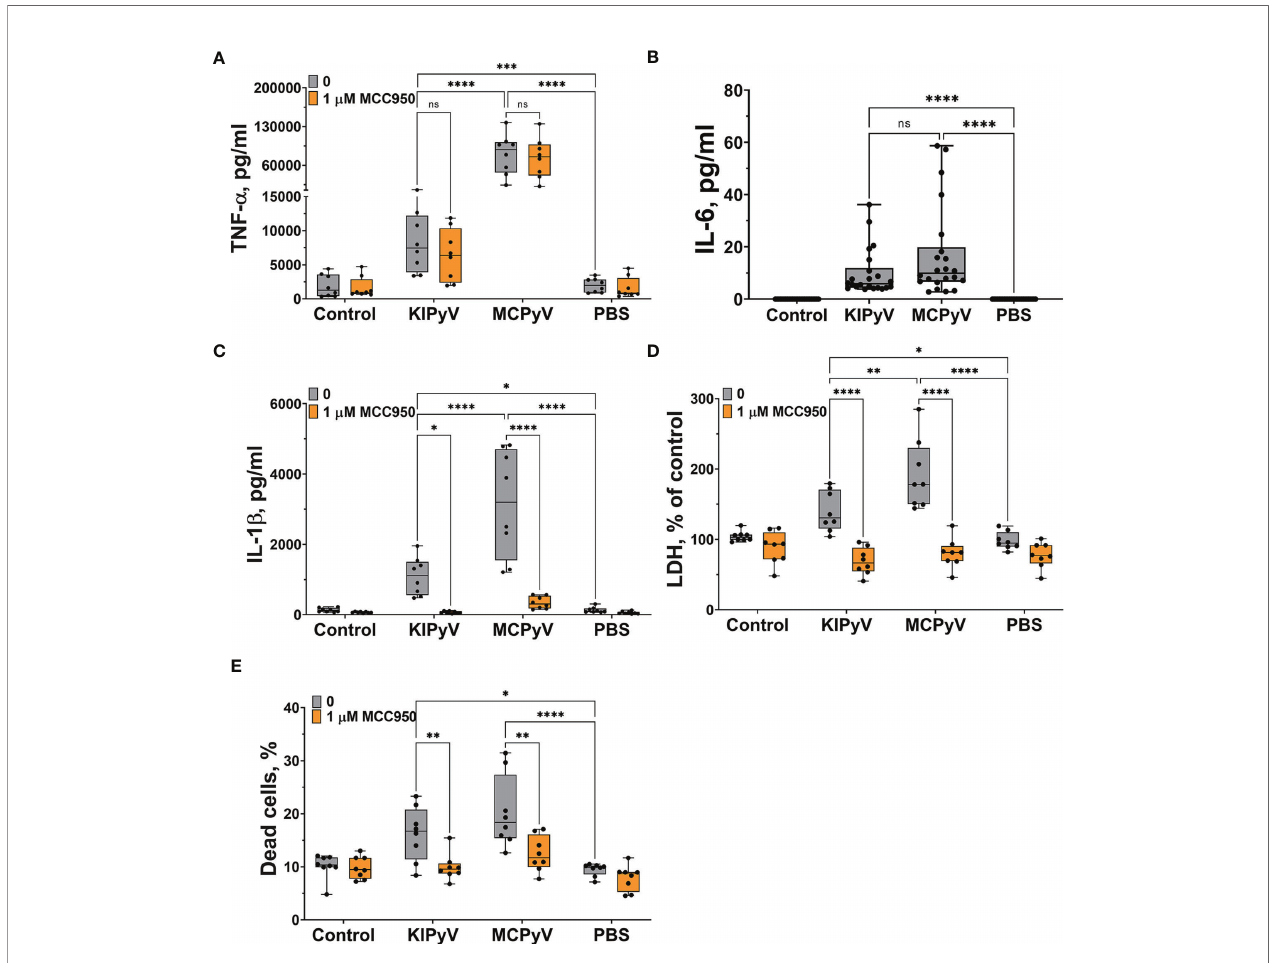
FIGURE 2 | PyV-derived VLPs induced release of in fl ammatory cytokines TNF- a and IL-6 and activated NLRP3 in fl ammasome in human THP-1 macrophages. Macrophages were treated with PyV-derived VLPs (20 µg/ml) for 24 h. Inhibitor MCC950 (1 m M) was added 30 min before treatment. (A) TNF- a , (B) IL-6, and (C) IL- 1 b secretion determined by ELISA. Cytotoxicity assessed by (D) LDH assay and (E) PI and Hoechst nuclear staining. PI indicates dead cells (red) and Hoechst stains all cell nuclei (blue). Data are represented using box plots with dots showing independent experiments, * p < 0.05, ** p < 0.01, *** p < 0.001, **** p < 0.0001, one-way ANOVA followed by Tukey ’ s multiple comparison test; ns, not statistically signi fi